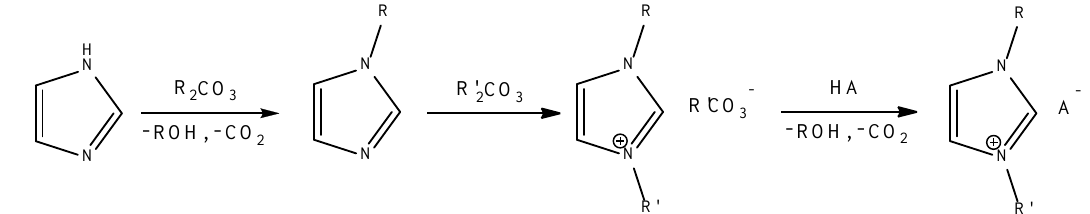
Figure 5. The CBILS ® (Carbonate-Based Ionic Liquid Synthesis) route for a 1,3-dialkylimidazolium based IL [196].